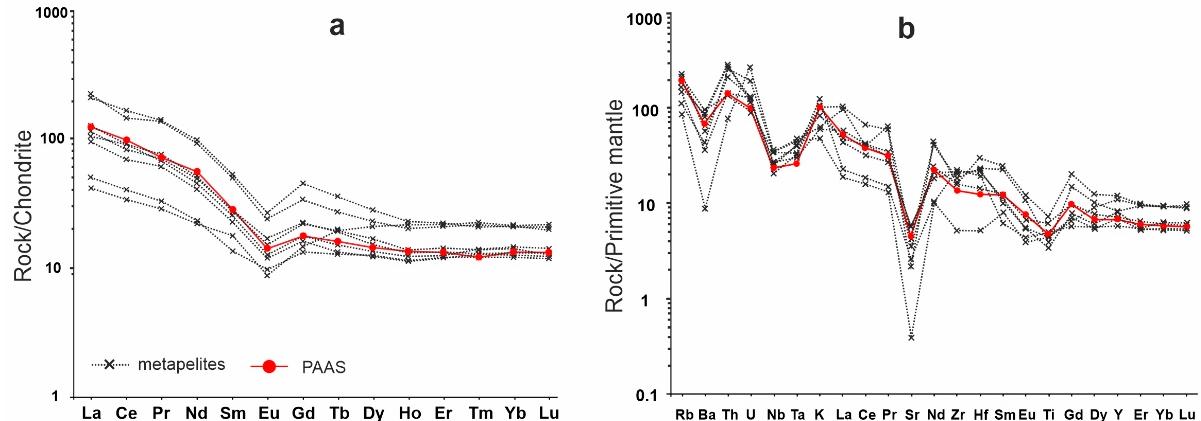
Figure 21. Chondrite-normalized REE patterns [99] ( a ) and primitive mantle-normalized spidergrams [101] ( b ) for the metapelites of the Teya and Angara Complexes.